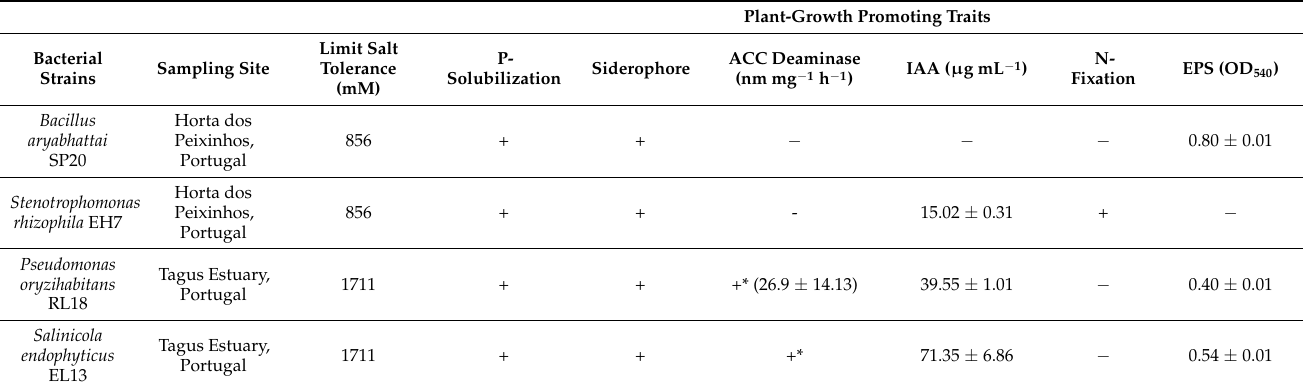
Table 1. Summary of the bacteria isolates and their plant growth-promoting properties [24]. Plant-Growth Promoting